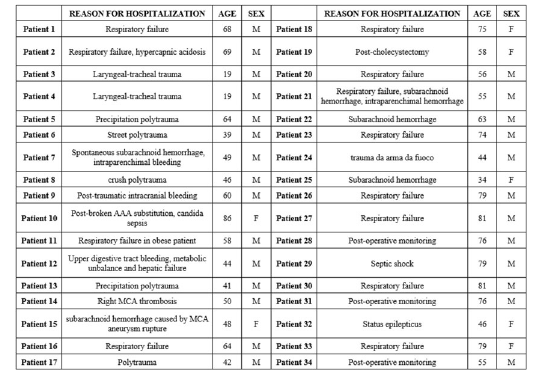
Table 1 (abstract 000822). A summary of the characteristics of studied